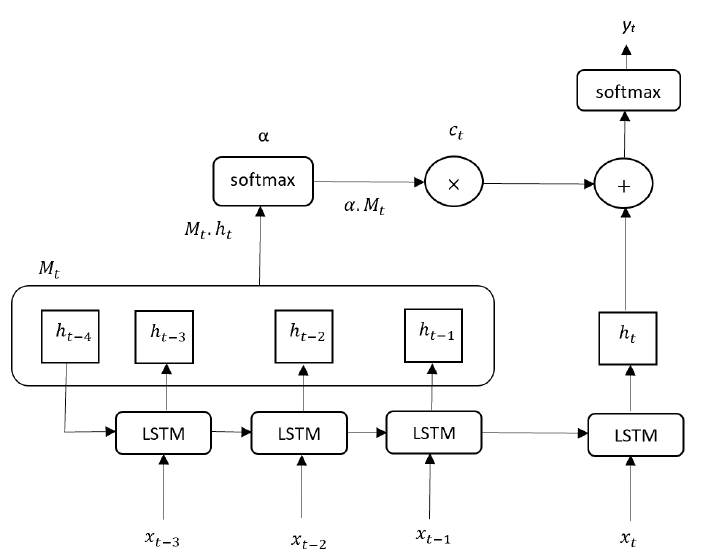
Figure 3. Architecture of proposed LSTM-AttM network model.